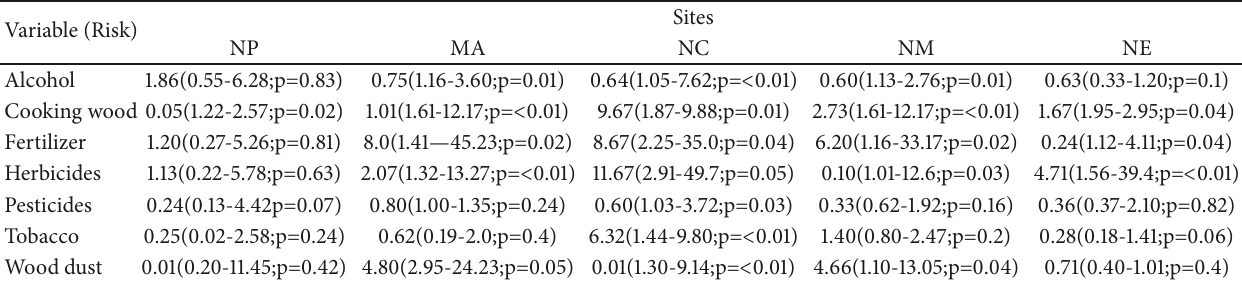
Table 4: Multivariate logistic regression showing odds ratios (95% CI) and p-values of covariates as risks for malignancy. Variable (Risk)